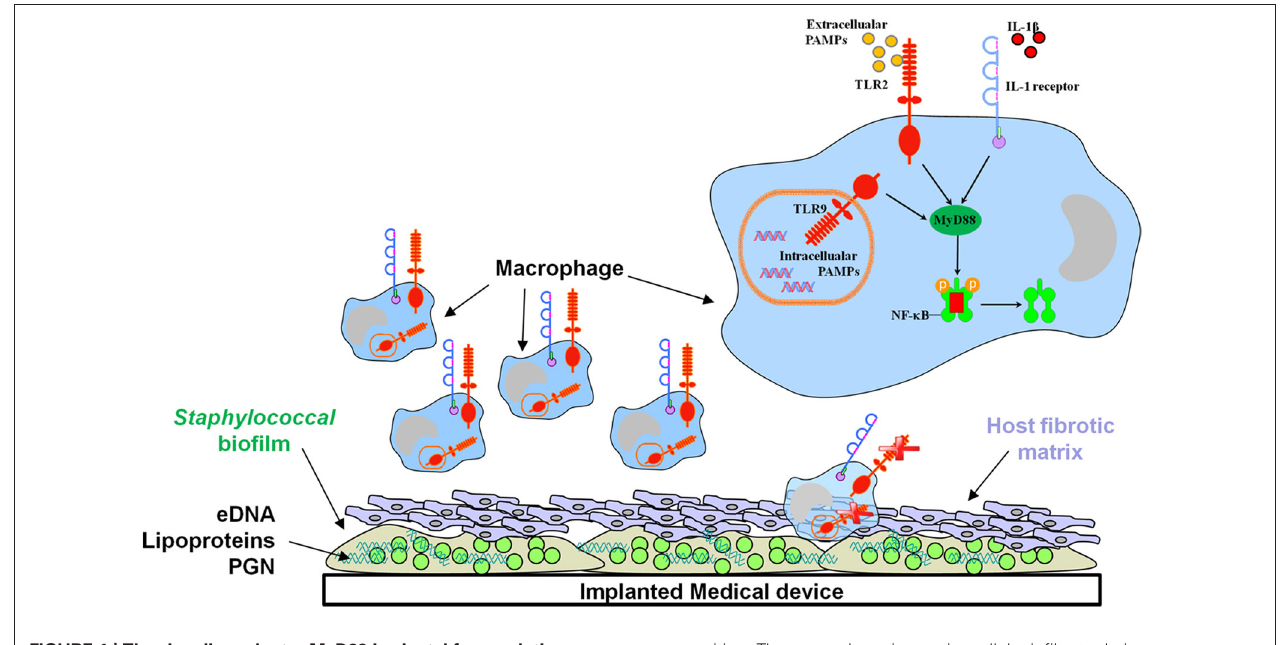
FIGURE 1 | The signaling adaptor MyD88 is pivotal for regulating biofilm development. Recent studies have revealed important roles for IL-1 β and MyD88-dependent pathways in controlling bacterial burdens during S. aureus biofilm growth, whereas biofilms evade TLR2/TLR9